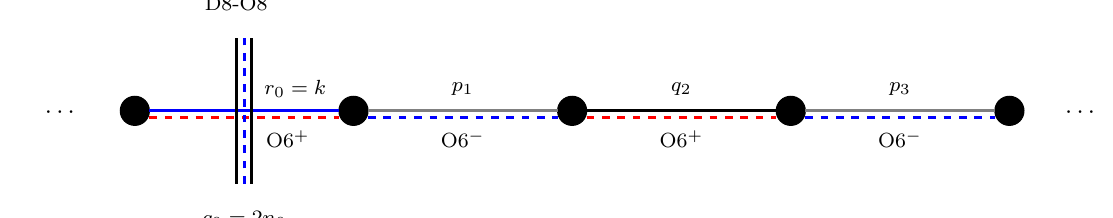
(b) NS5-D6-O6-D8-O8 con(cid:12)guration with O8 (cid:0) -plane between an NS5 and its image, and crossing the 0-th D6-O6 + stack. A blue vertical dashed line paired up with two black lines represent an O8 (cid:0) overlaid onto n 0 pairs of D8-branes, engineering an SO(2 n 0 ) (cid:13)avor symmetry and contributing 2 n 0 half-hypermultiplets. A blue (gray/black) horizonatal line represents a D6 stack engineering an SU ( SO/ USp) gauge group.